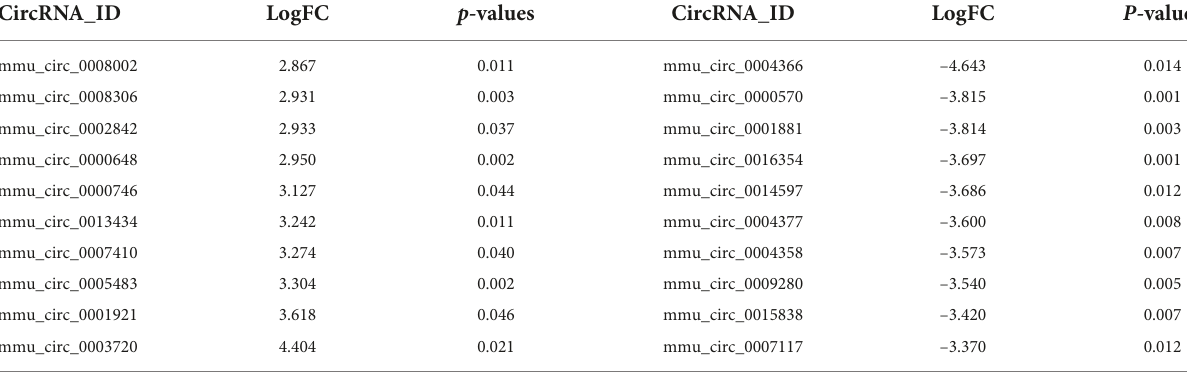
TABLE 3 The top 10 upregulated and downregulated genes of